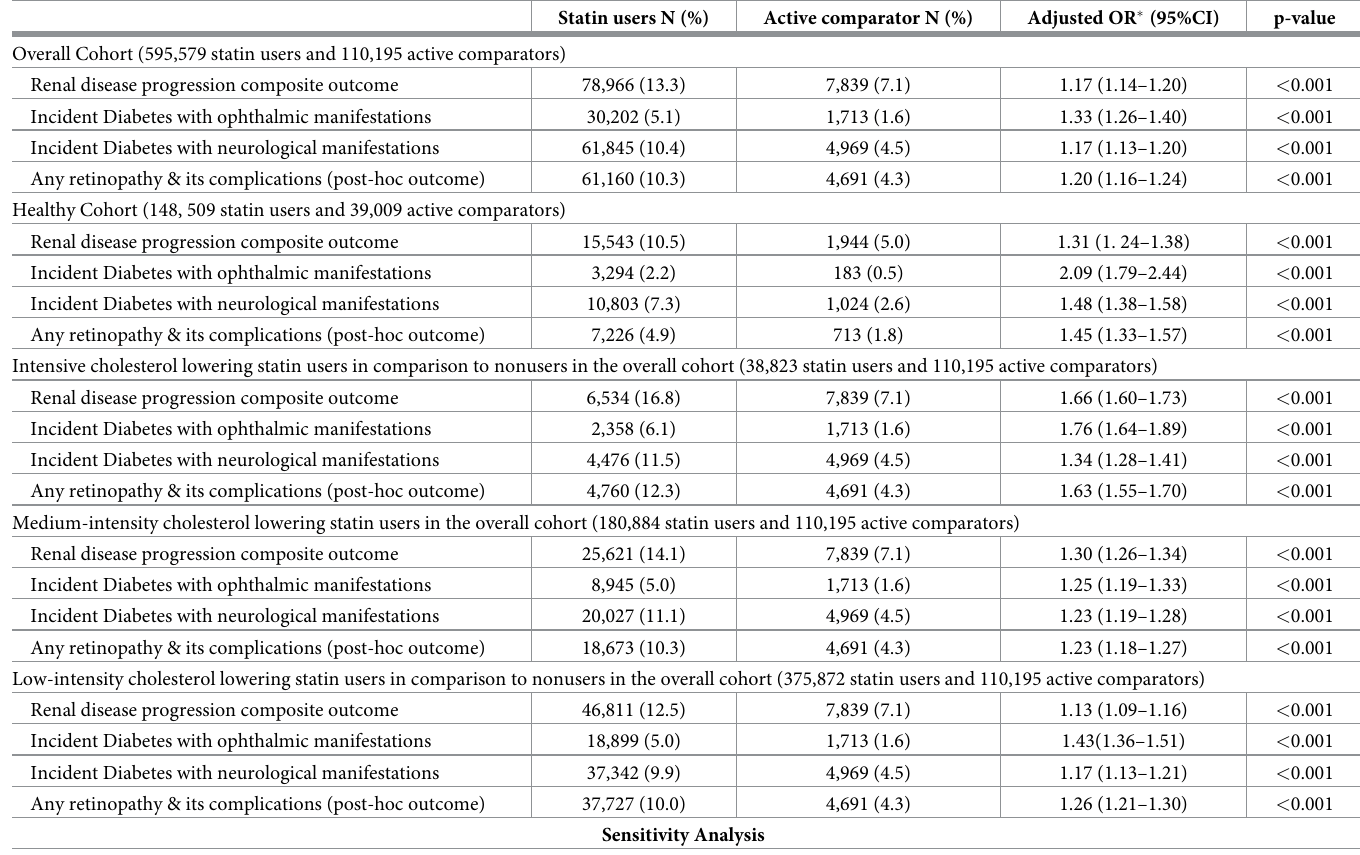
Table 3. Secondary analysis and sensitivity analysis comparing outcomes during follow between statin users vs active